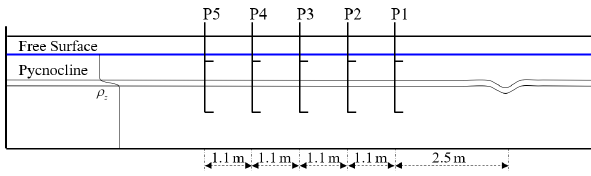
Figure 6. Schematic diagram of probe position (P1–P5) (Hsieh et al.,